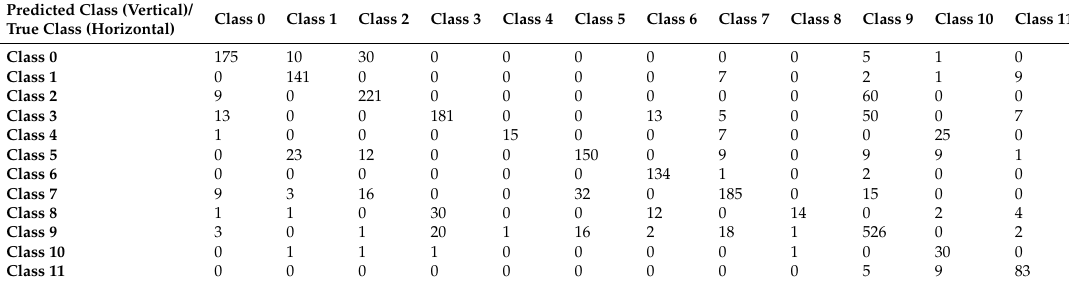
Table 10. Confusion matrix